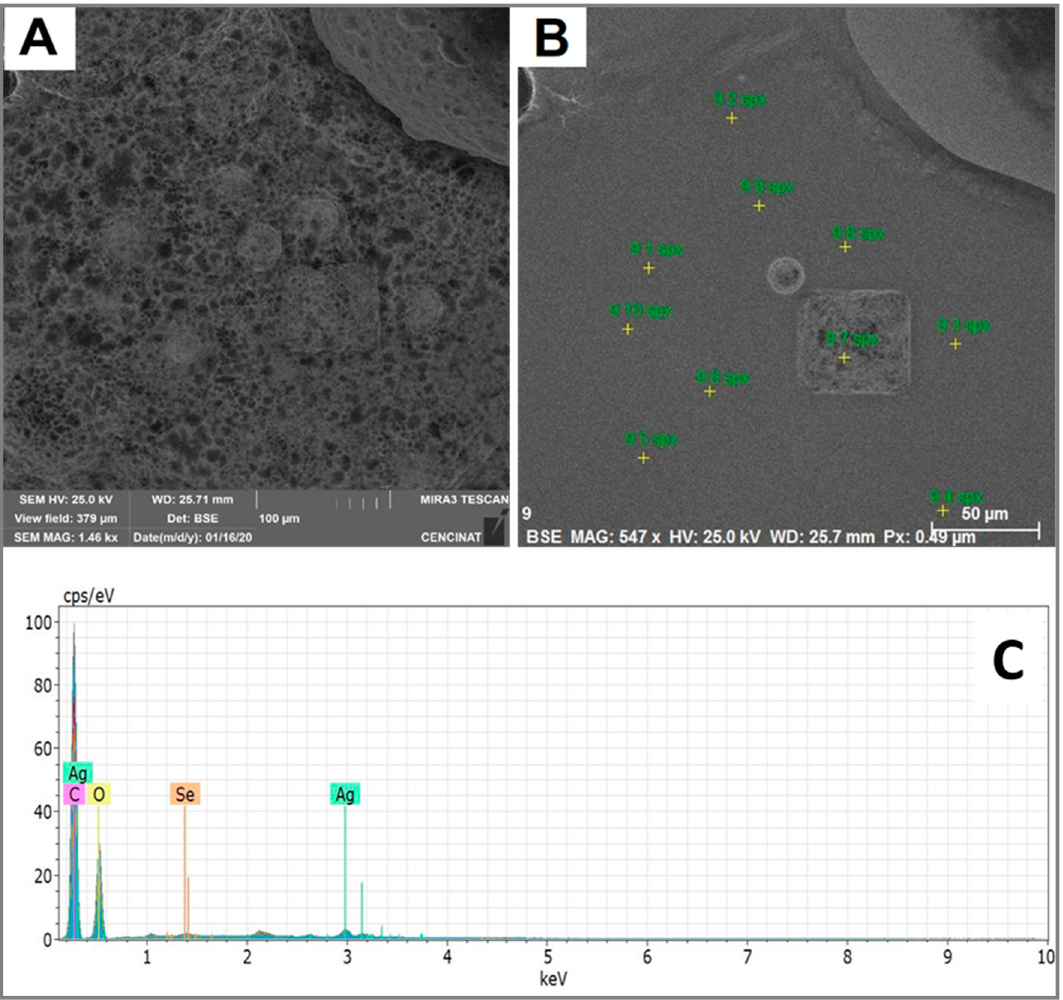
Figure 8. ( A ) SEM image; ( B ) selected areas for EDS spot analysis; and ( C ) EDS representative spectrum of Ag 2 Se NPs.